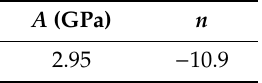
Figure 4. Analysis model of the inertial effect of the specimens in SHPB tests. 𝑑 (cid:3046) and 𝑙 (cid:3046) are the diameter and the thickness of a specimen, respectively. S is the reference position in the axial coordinate; 𝑣 (cid:2869) and 𝑣 (cid:2870) are the velocities at specimen ends. 𝑣 (cid:3031) is the deformation velocity of a specimen; P1 and P2 are the pressure forces on the interaction surface between the specimen and bars. 𝑓 (cid:2869) and 𝑓 (cid:2870) are the friction forces caused by P1 and P2.